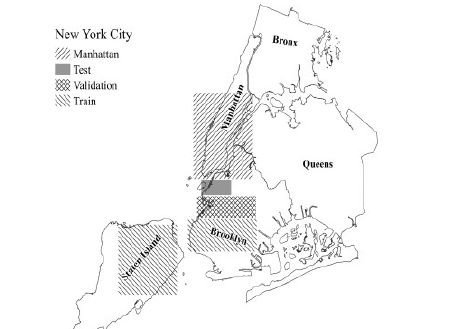
Figure 5. Districts of New York City and the experiment dataset geographical extent. Original data source (New York City Open Data Portal). Figure 7. Class imbalance. The number of background pixels is much higher than those of corresponding thematic features. This imbalance increases when the image resolution is higher (sparsity